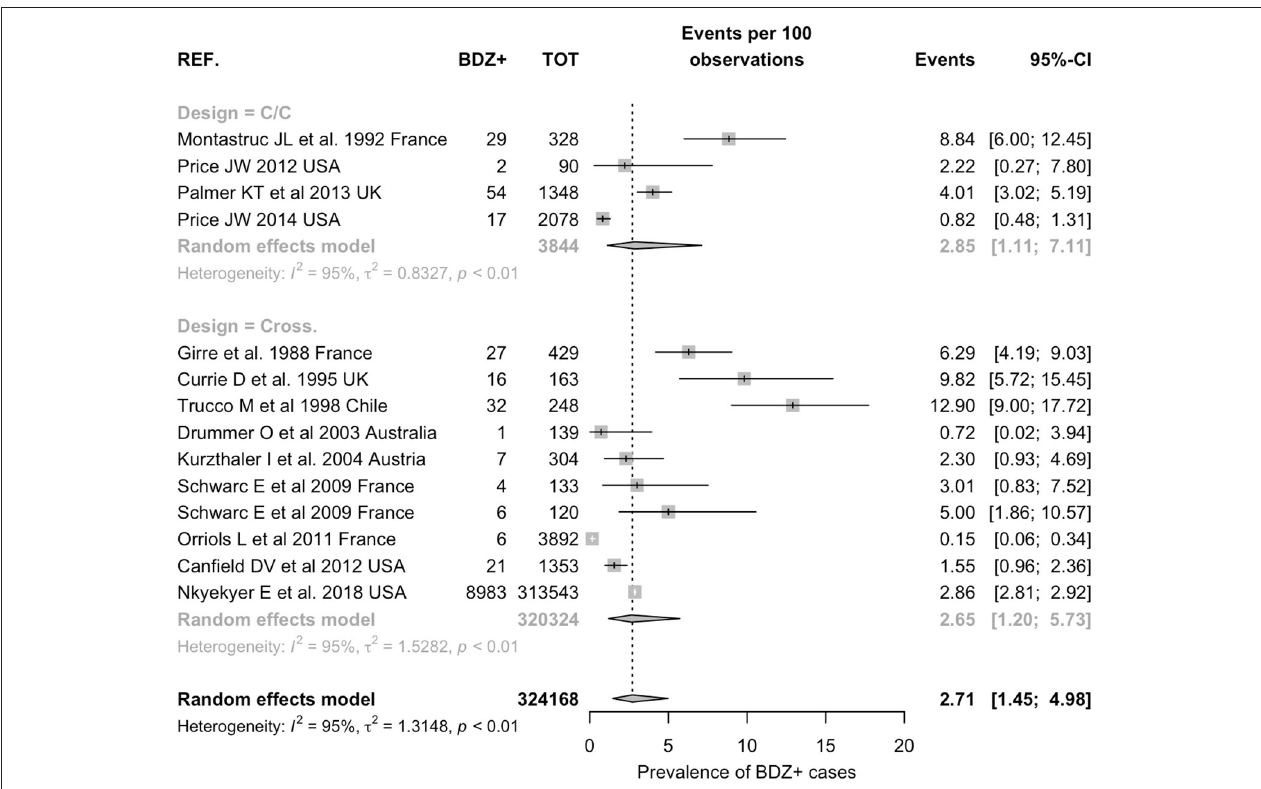
FIGURE 2 | Prevalence of positive status for benzodiazepine use in occupational injuries. Pooled prevalence was estimated in 2.71% (95% Confidence Interval 1.45, 4.98) with substantial heterogeneity